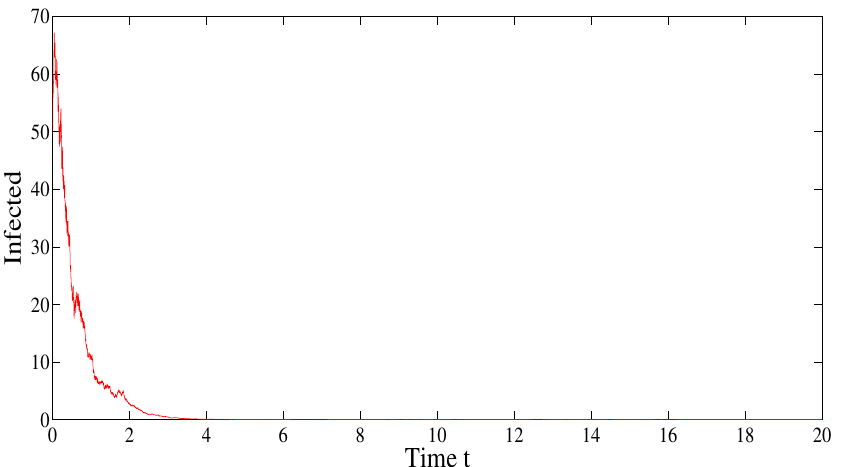
Figure 3. The infected population as a function of time when λ = 10, µ = 0.0125, β = 0.0001, γ 2 = 1, γ 1 = 0.1, (cid:101) = 0.33, δ = 0.09 and d = 0.025.